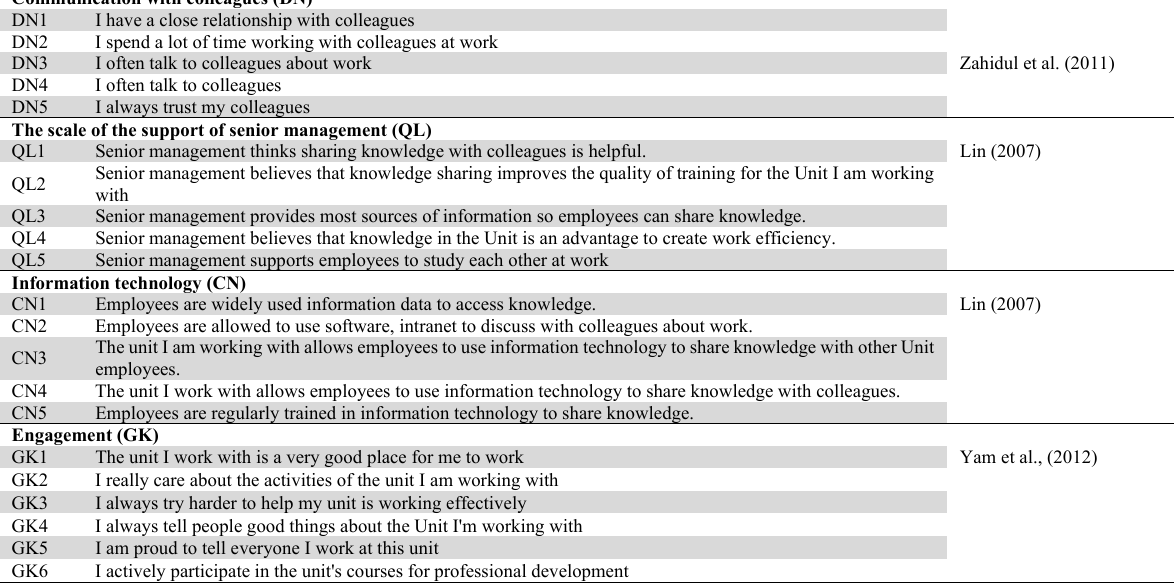
Scale Variance if Item Deleted